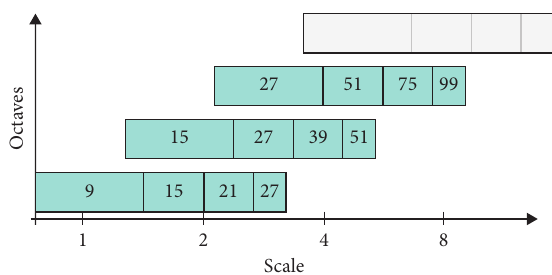
Figure 7: The filter side length of different octaves.